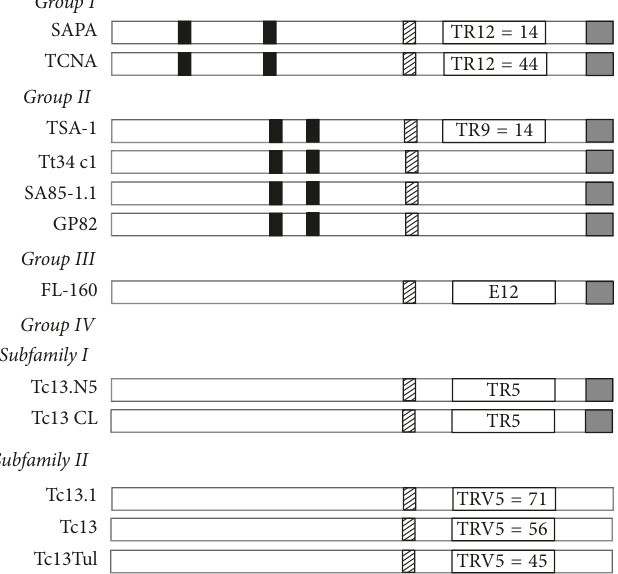
Figure 3: Trans-sialidase (TS) superfamily. Schematic representation of the four different groups of trans-sialidases (TS) from Trypanosoma cruzi . Characteristic motifs SXDXGTW and VTVXNVXLYNR for TS are depicted as black and shadowed boxes, respectively. The glycosylphosphatidylinositol- (GPI-) anchor signal in the C-terminus position is shown as grey boxes. Tandem repeats (TR) of 12 amino acid residues [DS 2 AH(S/G)TPSTP(A/V)] are detected in SAPA and TCNA (TR12 inside an open box). Nine amino acid residue repeats [DK 2 ESESGDSE] are identified in TSA-1 (TR9 inside an open box). A characteristic epitope [TPQRKT 2 EDRPQ] is present in FL-160